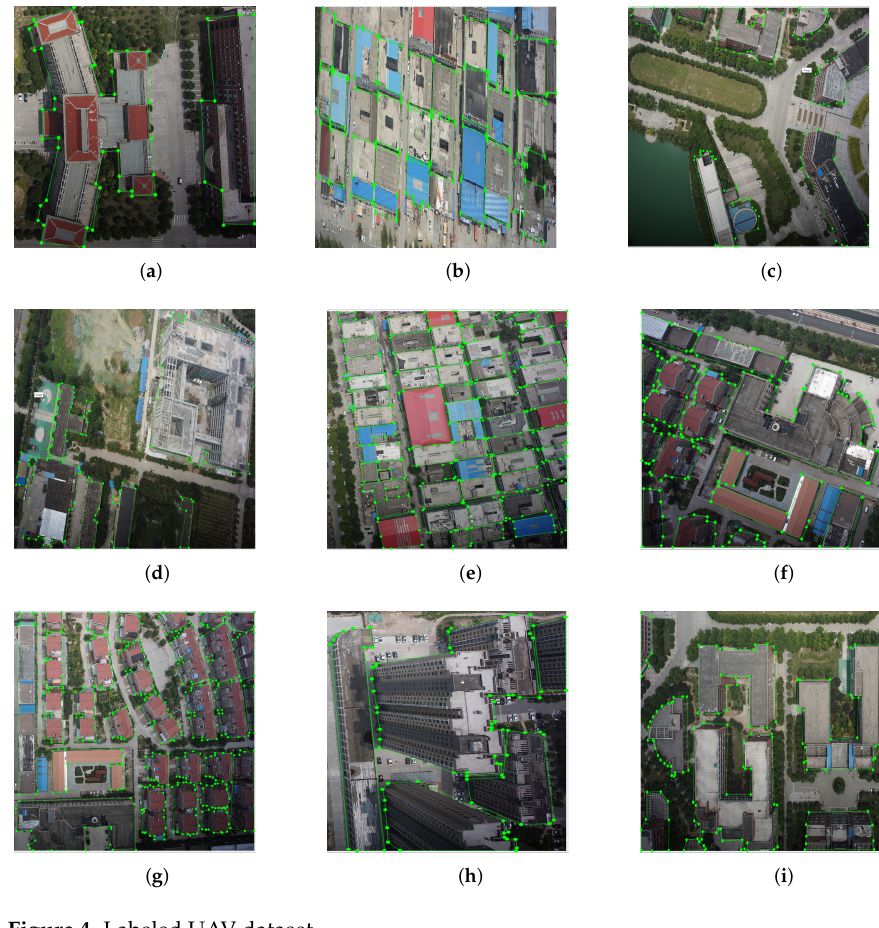
Figure 4. Labeled UAV dataset.